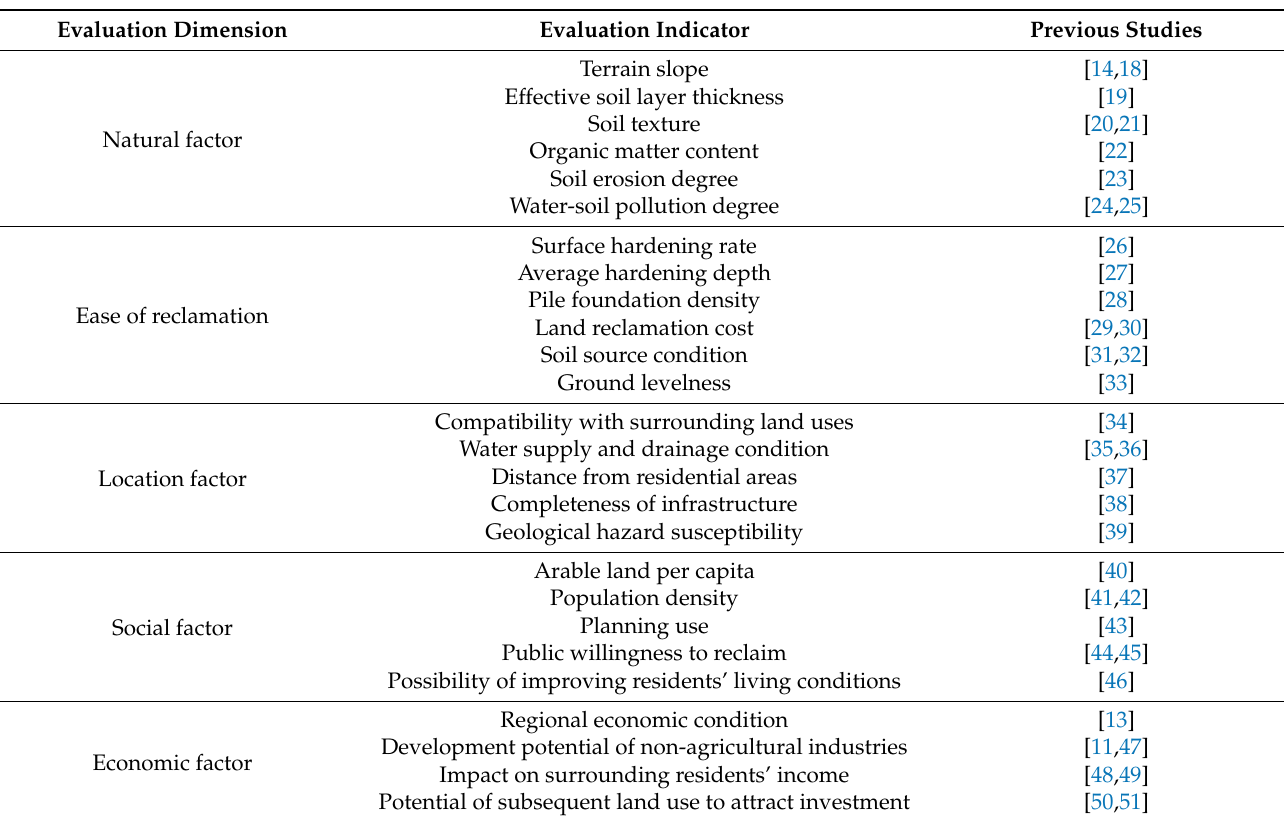
Table 1. Identification of LRS evaluation indicators through literature